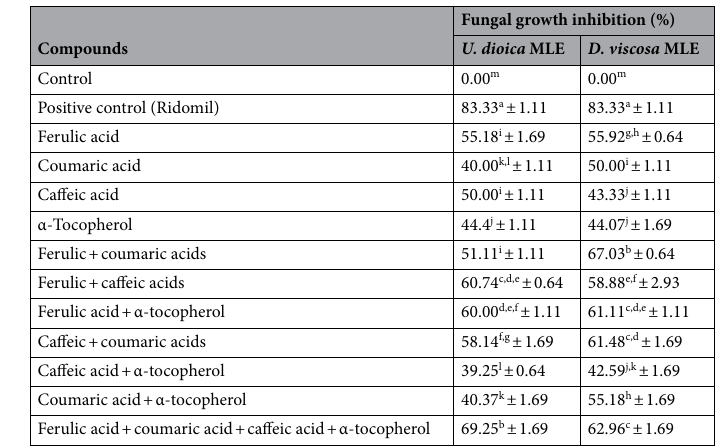
Table 4. The most abundant phenolic compounds identified in the leaf methanol extract from U. dioica and D. viscosa by HPLC and their mixtures used in vitro against A. alternata isolate. Means with the same letter are not significantly different according to LSD at 0.05 level of probability.